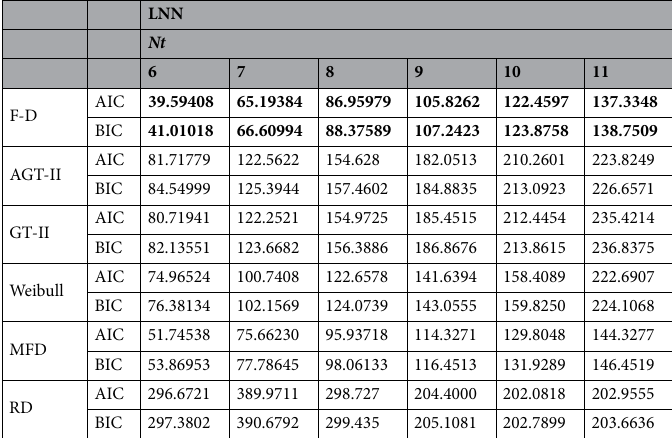
Table 6. Akaike information criteria (AIC) and (BIC) for the